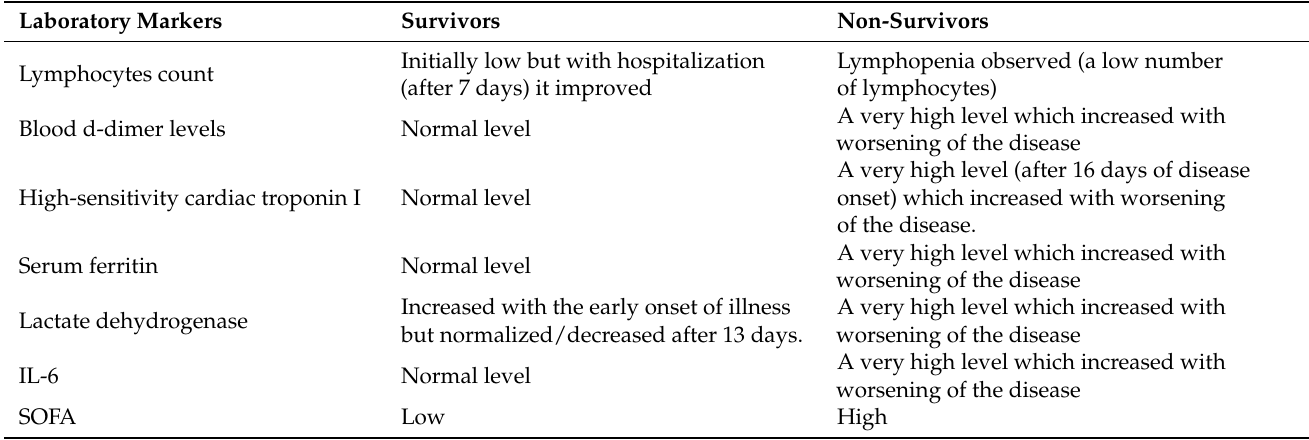
Table 4. Differentiation of various biomarkers among survivors and